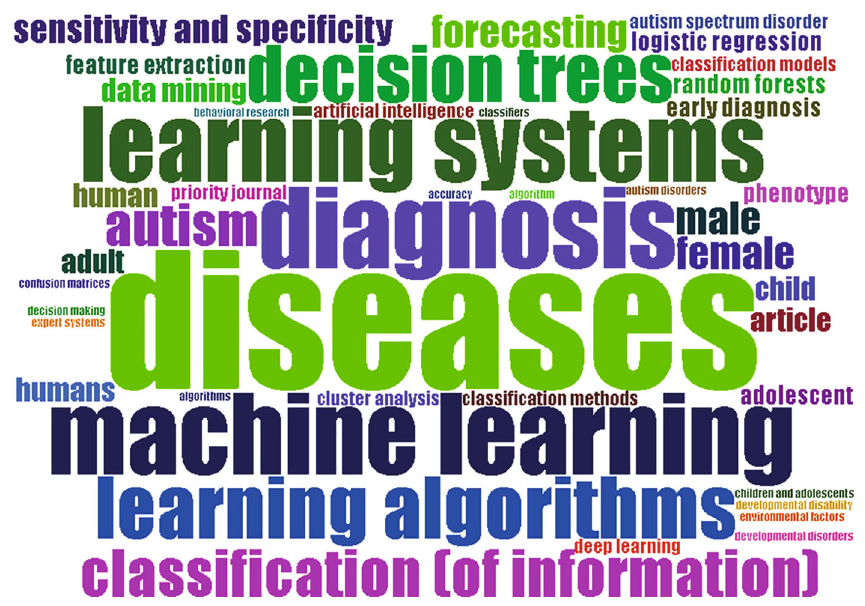
Figure 3: Word cloud.